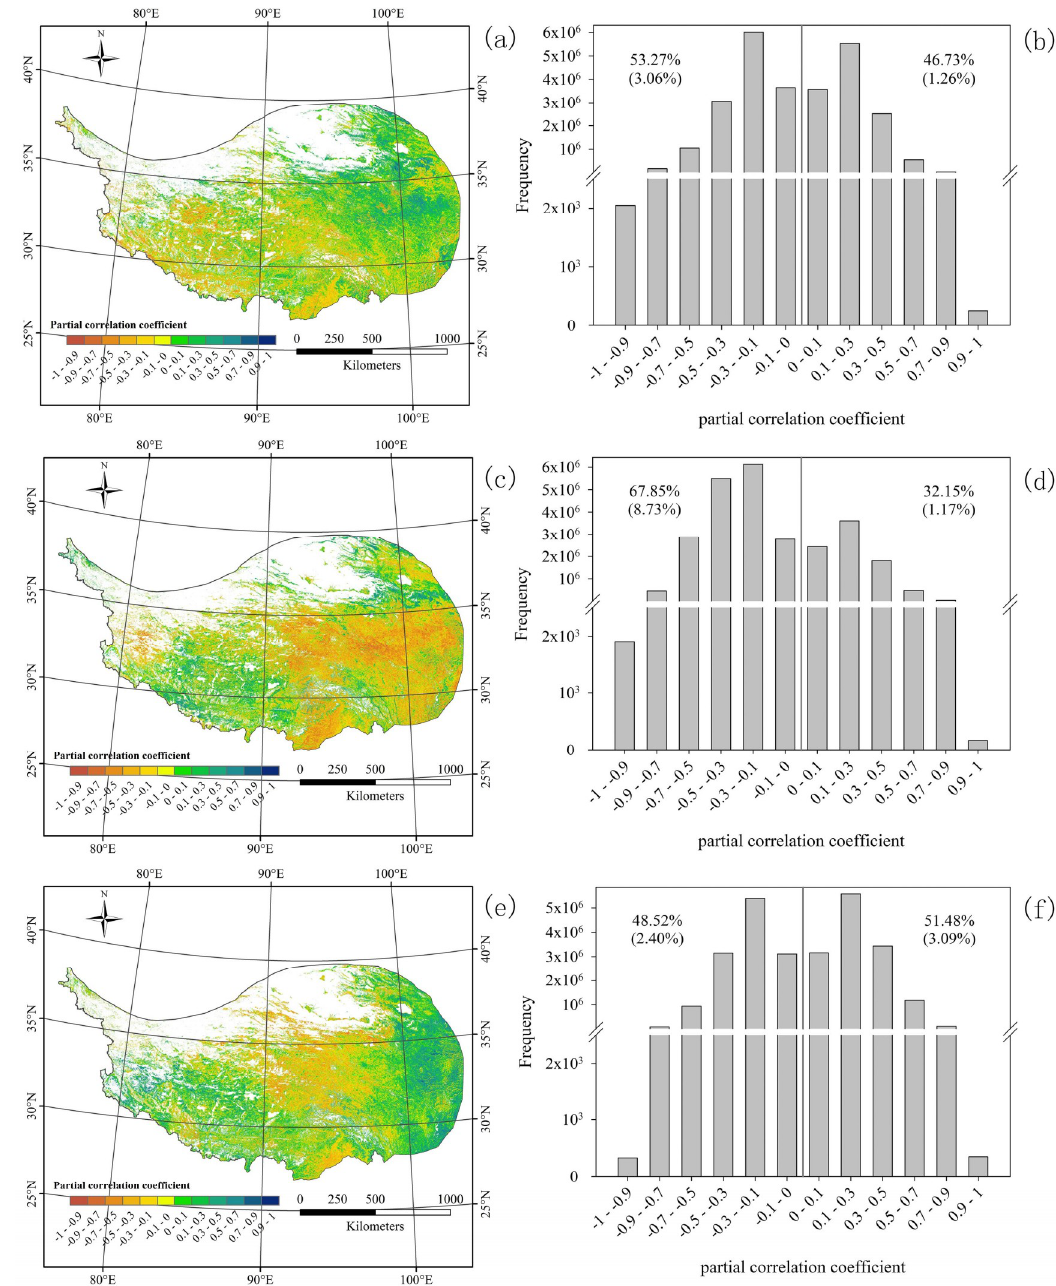
Figure 4. Spatial distribution of sensitivity of NPP to ( a , d ) temperature, ( b , e ) total precipitation, and ( c , f ) total solar radiation, with corresponding frequency distributions. Note that only pixels with both the regression model and their corresponding coefficients that were significant simultaneously are shown. Tem, Pre, and Rad represent mean temperature, cumulative precipitation, and cumulative solar radiation,